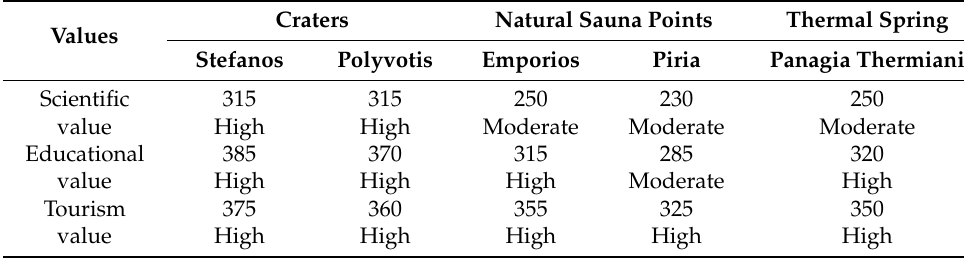
Table 6. Final scores for G-P